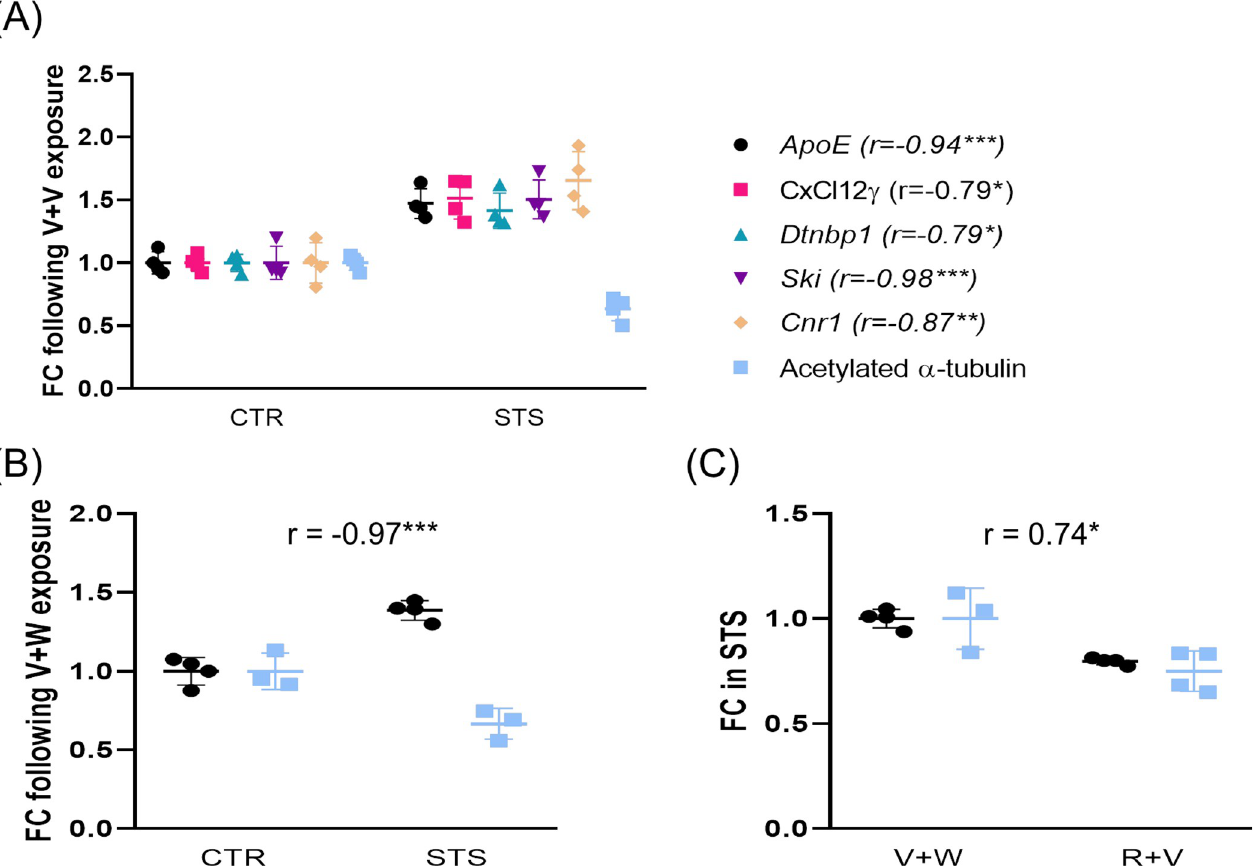
Fig 4. Correlation analysis between acetylated α -tubulin at K40 and gene expression in the prefrontal cortex. We reported an inverse association between acetylated α -tubulin levels and either ApoE , CxCl12 γ , Dtnbp1 , Ski , or Cnr1 when compared controls and defeat mice subjected to V+V (panel A); and also did the expression of ApoE upon V+W treatment when comparing the control and the stress group (panel B). A positive correlation between acetylated α -tubulin and ApoE was reported between V+W and R+V under stress conditions (panel C). CTR, control; STS, stress; V, vehicle; W, WIN55,212–2; R, rimonabant. One, two or three symbols indicate P < 0.05; P < 0.01, P < 0.001, respectively.